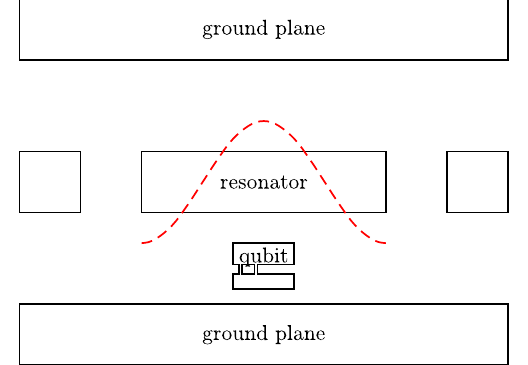
FIG. 18. Schematic illustration of the transmon qubit [53]. The qubit (lower-middle) is embedded inside a coplanar waveguide (two ground planes with a feed line running through the center). The short section of feed line traps a standing wave (shown in red) and can thus be thought of as a resonator. The qubit (in this case, two superconductors connected by a split Josephson junction) is capacitively coupled to the resonator and slightly shifts the resonator ’ s frequency. A wave traveling down the feed line will experience an impedance mismatch due to the resonator or qubit. This will result in a transmission amplitude S 21 whose value depends on the state of the